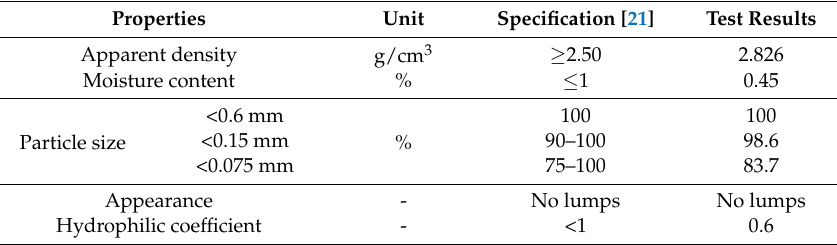
Table 5. Properties of mineral